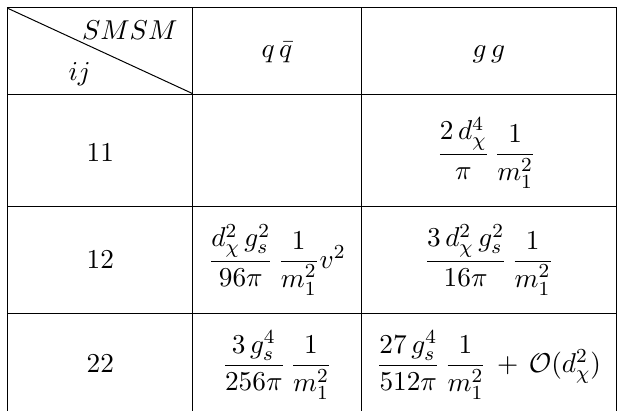
Table 1 . Di(cid:11)erent contributions to the e(cid:11)ective cross-section is denoted by g s , while v is the relative velocity in the (cid:31) i (cid:31) j center-of-mass frame. where (cid:11) g =g (1 + (cid:1) m=m ) 3 = 2 e (cid:0) x (cid:1) m=m 1 , x 2 1 1 (cid:17) is the number of degrees of freedom of (cid:31) e(cid:11)ective cross-section